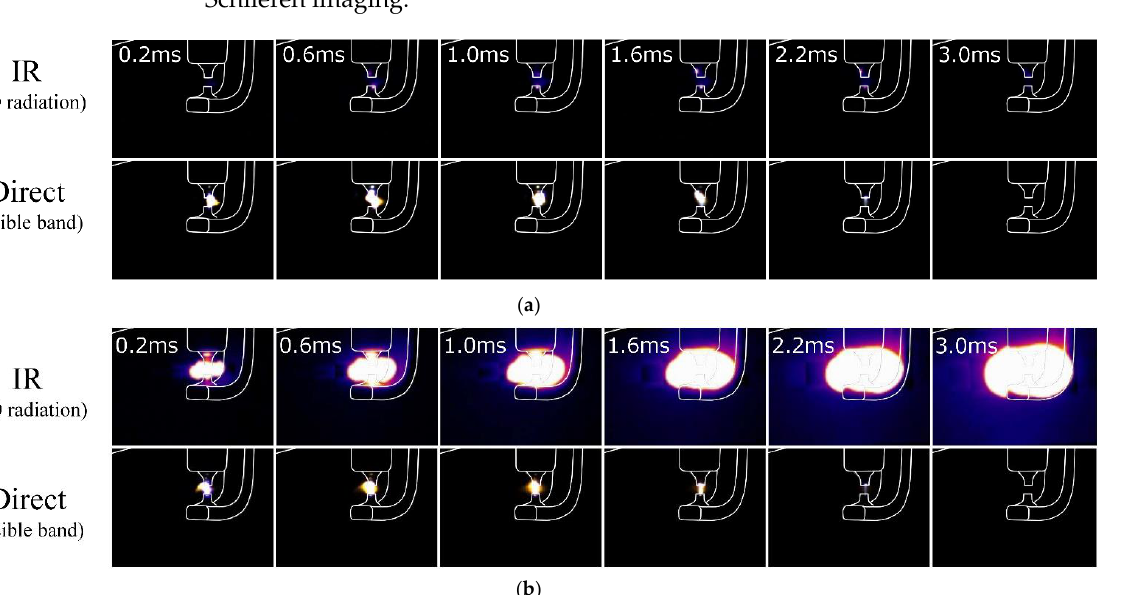
Figure 4. IR absorbance spectrum.